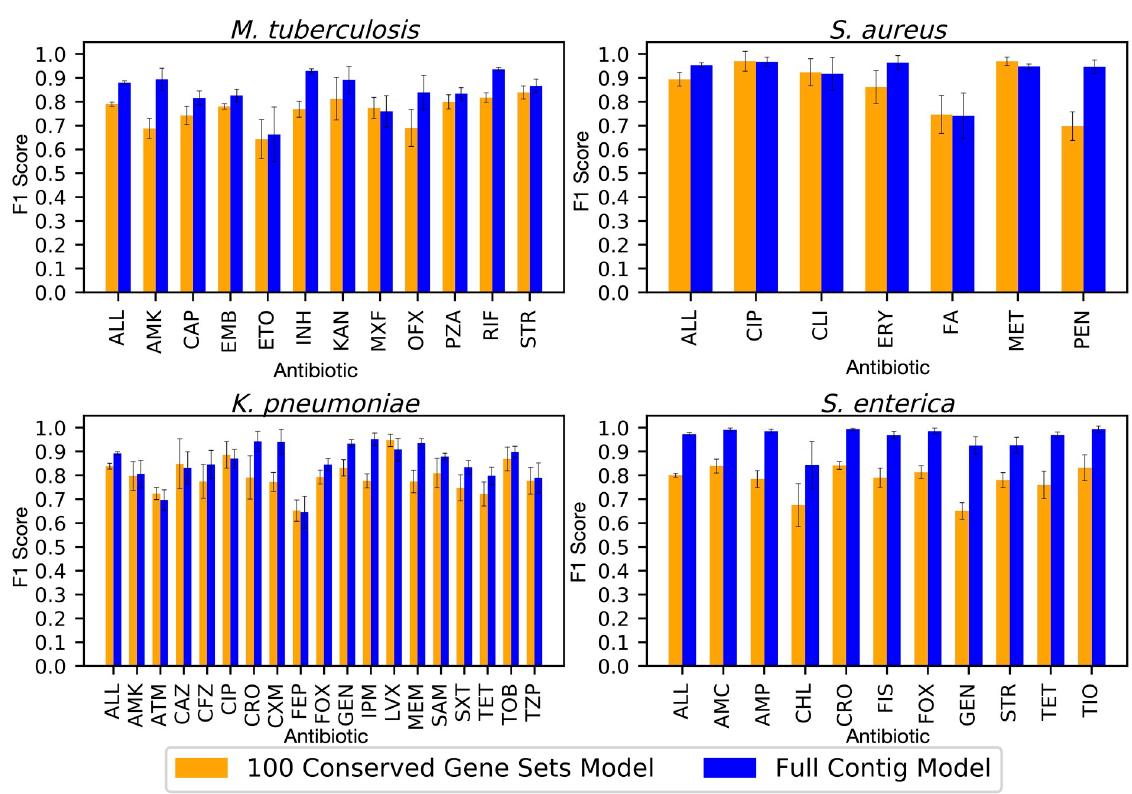
Fig 2. Average F1 scores by antibiotic for ten models built from non-overlapping sets of 100 core genes (orange bars) compared with the F1 scores for models built from whole assembled contigs for the same genomes (blue bars). Error bars represent 95% confidence intervals for the whole genome model, and the minimum and maximum confidence interval observed in all ten replicates for the core gene models. Antibiotic abbreviations are defined in Table 2.